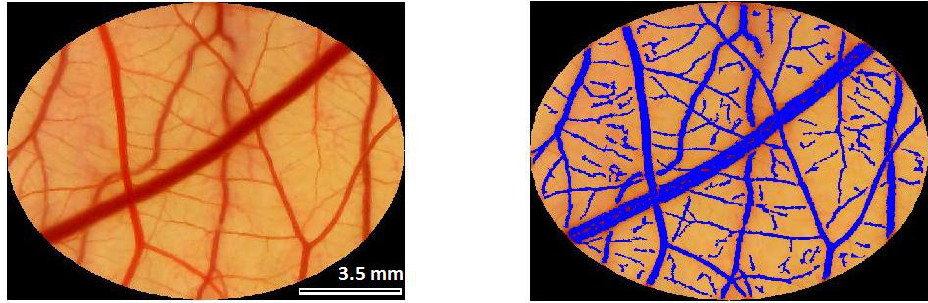
Figure 6. Processing the Chorioallantoic Membrane (CAM) image with MATLAB® routine.